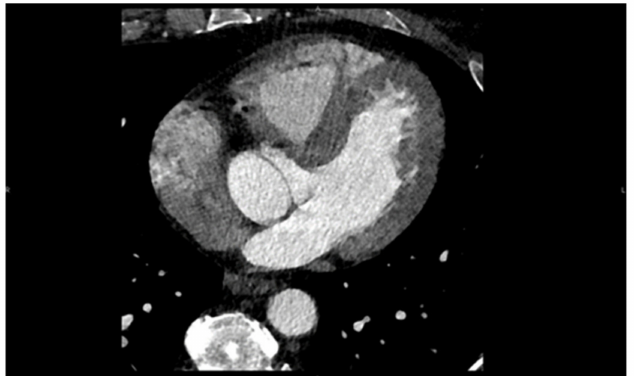
Figure 11. Computed tomography (CT) image of the left and right ventricle, left atrium, and ascending aorta.